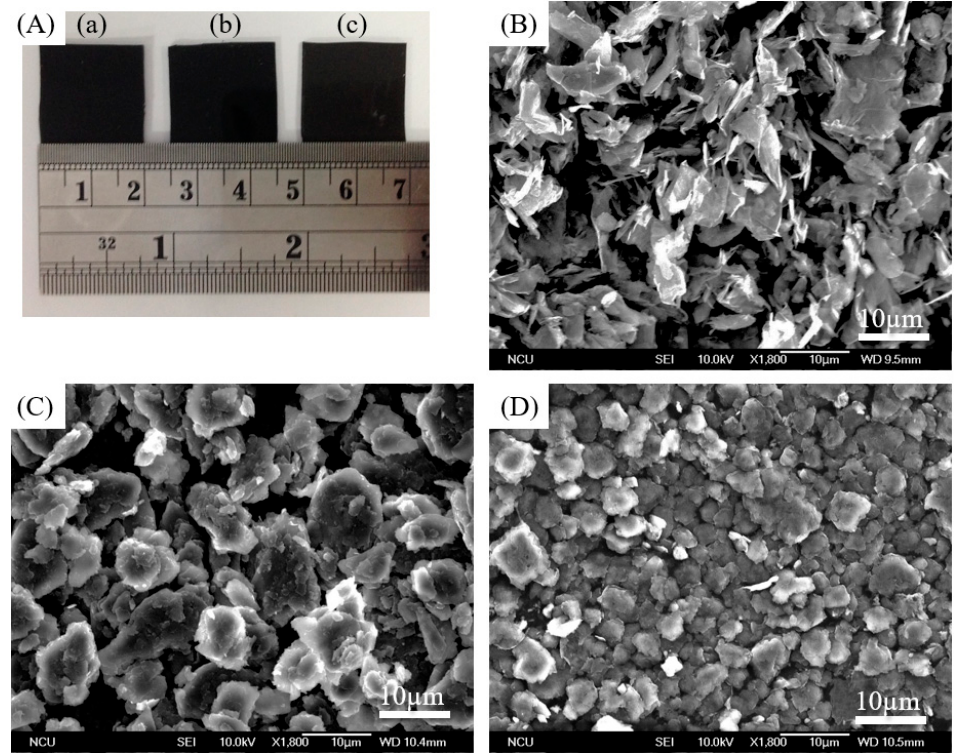
Figure 4. SEM images of EGN, recycled 2B and BMEGN. ( A ) Digital photos of ( A - a ) EGN, ( A - b ) recycled 2B, ( A - c ) BMEGN; ( B – D ) SEM images of ( B ) EGN, ( C ) ball-milled for 4 h recycled lead-graphite pencils (recycled 2B), and ( D ) ball-milled for 4 h exfoliated graphite nanoplatelets (BMEGNs).